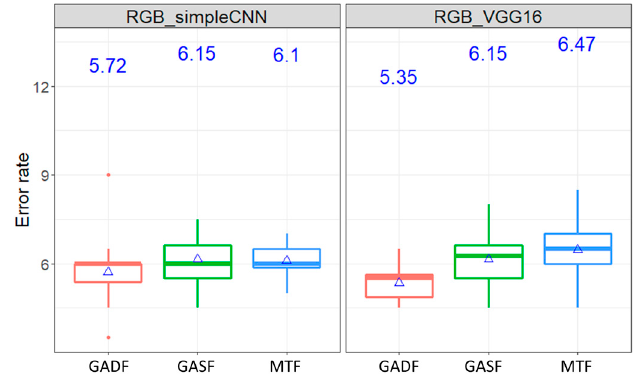
Figure 8. The boxplot of error rates of classifying RGB ECG dataset images using simple ConvNet and VGG16. Table 3. Average execution times (in seconds) of the simple ConvNet and VGG16 in processing the Wafer and ECG dataset images, separated by three data transformation methods.